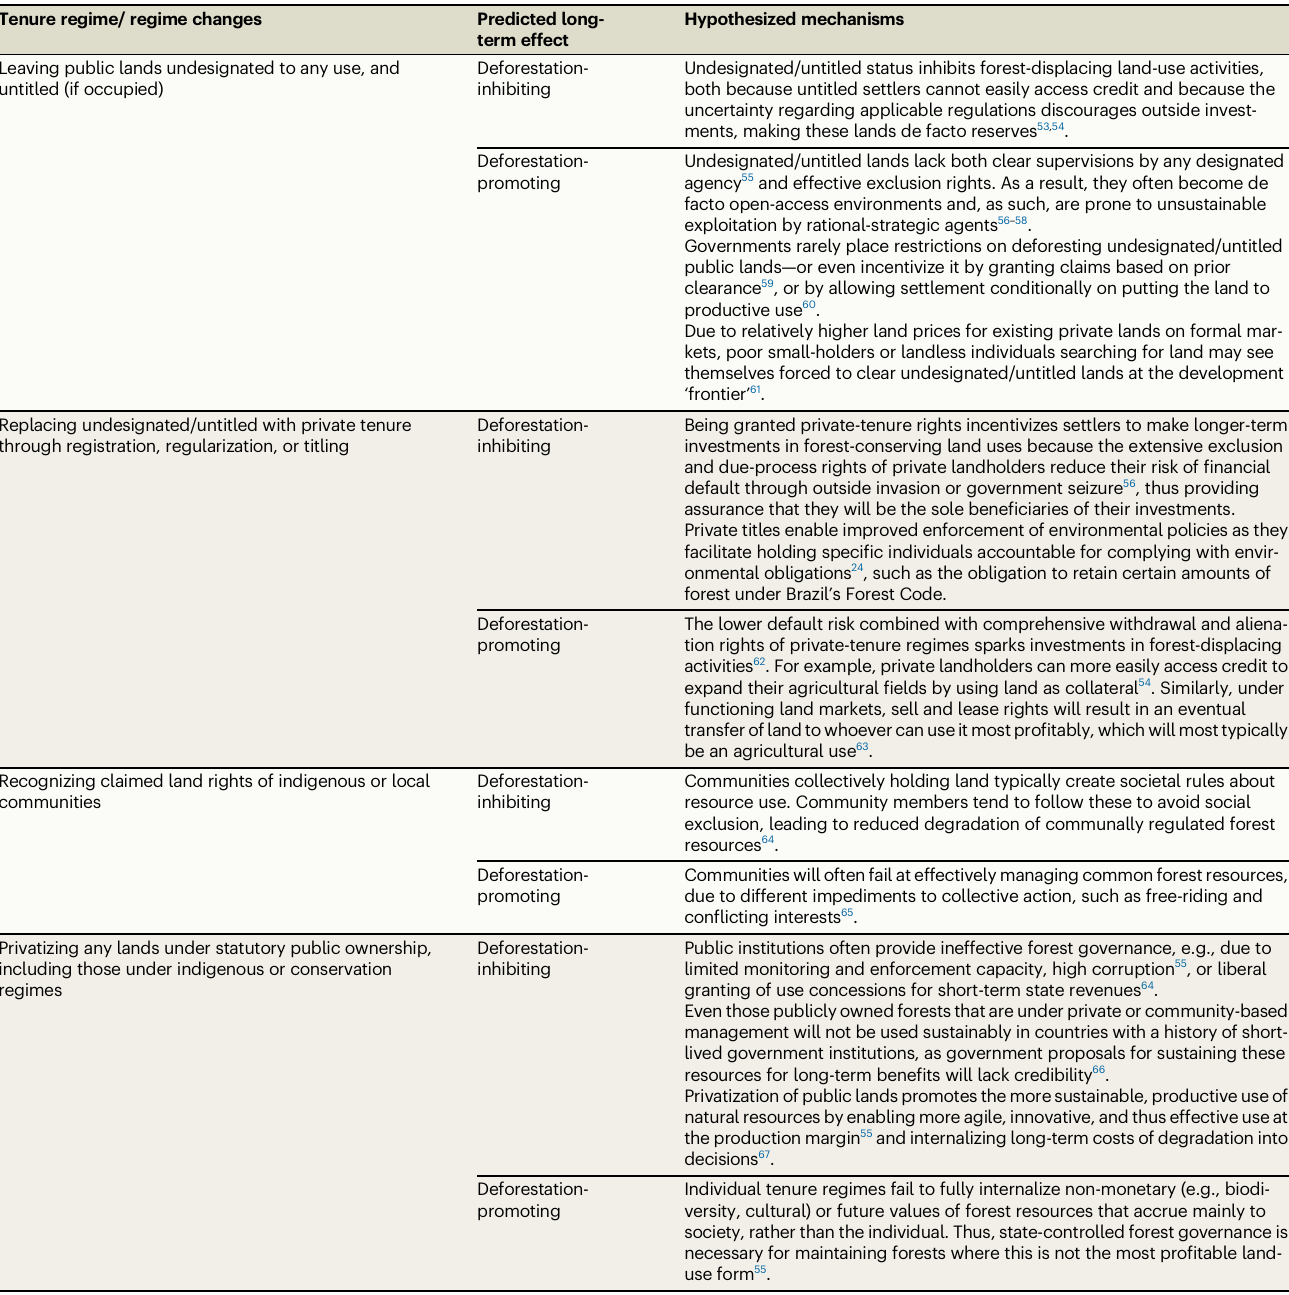
Table 1 | Exemplary hypothesized deforestation effects of different tenure regimes and regime changes Tenure regime/ regime